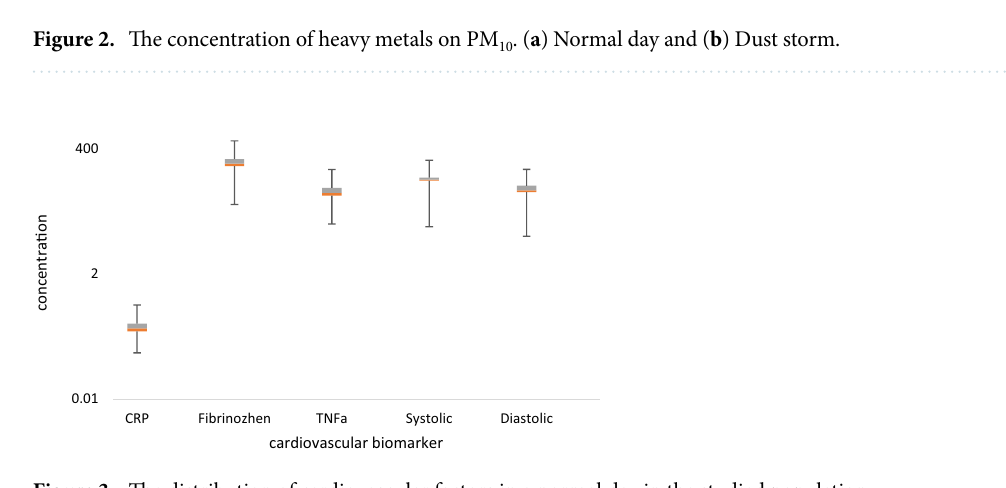
Figure 3. The distribution of cardiovascular factors in a normal day in the studied population.